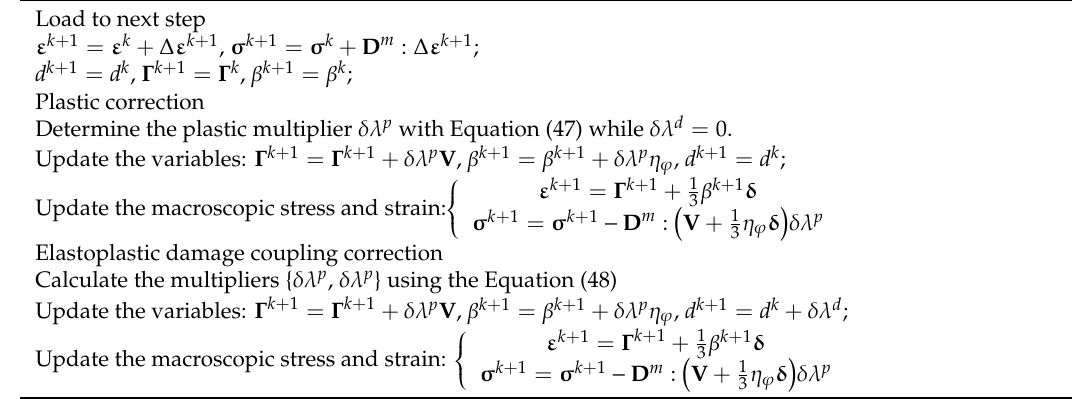
Table 3. Flowchart of return mapping algorithm of the micromechanical based